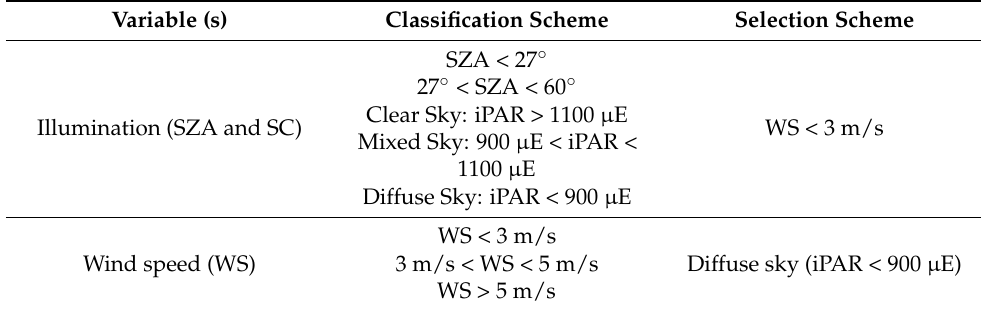
Wind speed (WS) Diffuse sky (iPAR < 900 µ